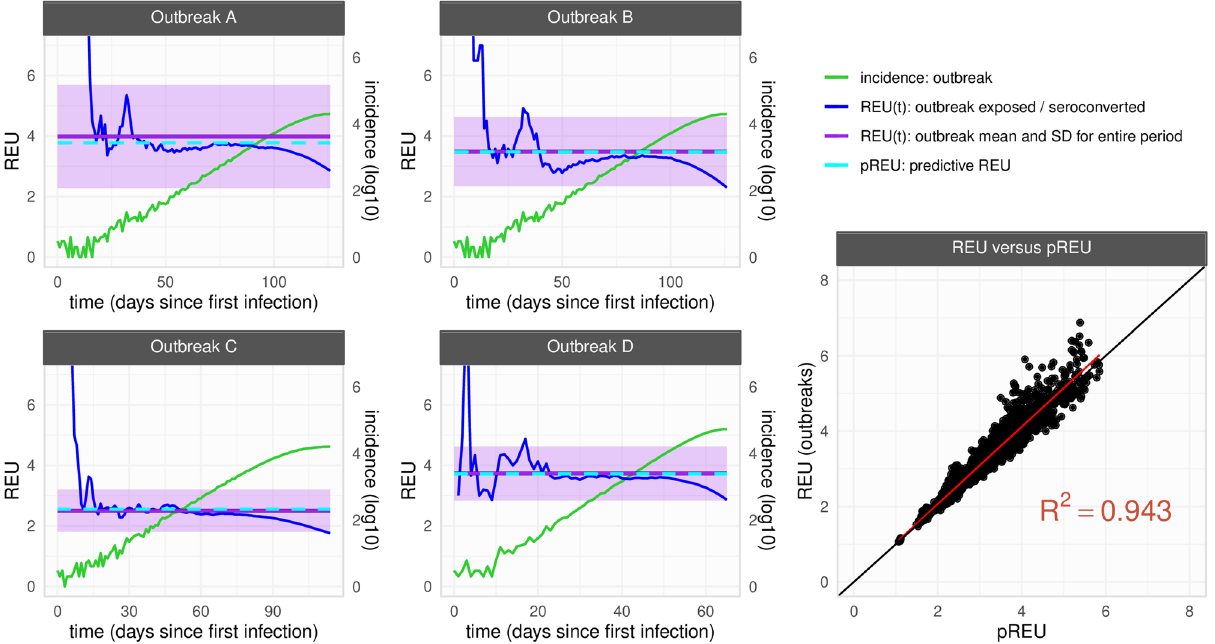
Figure 2. Summarizing exposure underestimation during epidemic growth. (left) Examples of simulated outbreaks ( A – D ) with parameter variations from the default parameter set (Fig. 1A–C, Table 1). Outbreak A with Ŵ m = 28 . Outbreak B with Ŵ s = 6 . Outbreak C with nC = 100. Outbreak D with R0 = 3.5. For each, the outbreak’s REU(t) (blue), incidence (green), REU mean and standard deviation for the entire time period (purple) and pREU (cyan) are presented. Time period considered is from the first case to outbreak peak. (right) Mean REU of each outbreak (N = 3100) and pREU shown with a linear regression with R-squared =